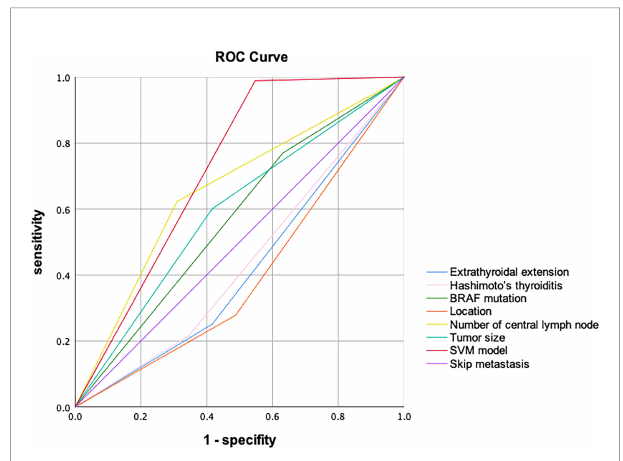
FIGURE 3 | The ROC Curve of the SVM model (The AUC is